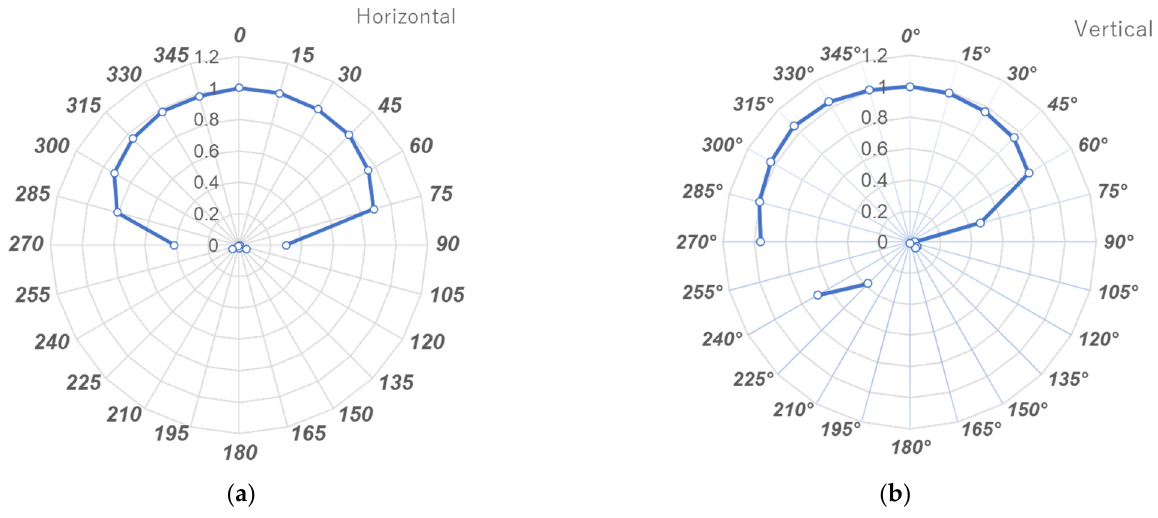
Figure 8. Angle dependency of the i3 sensor: ( a ) Horizontal plane; ( b ) Vertical plane.